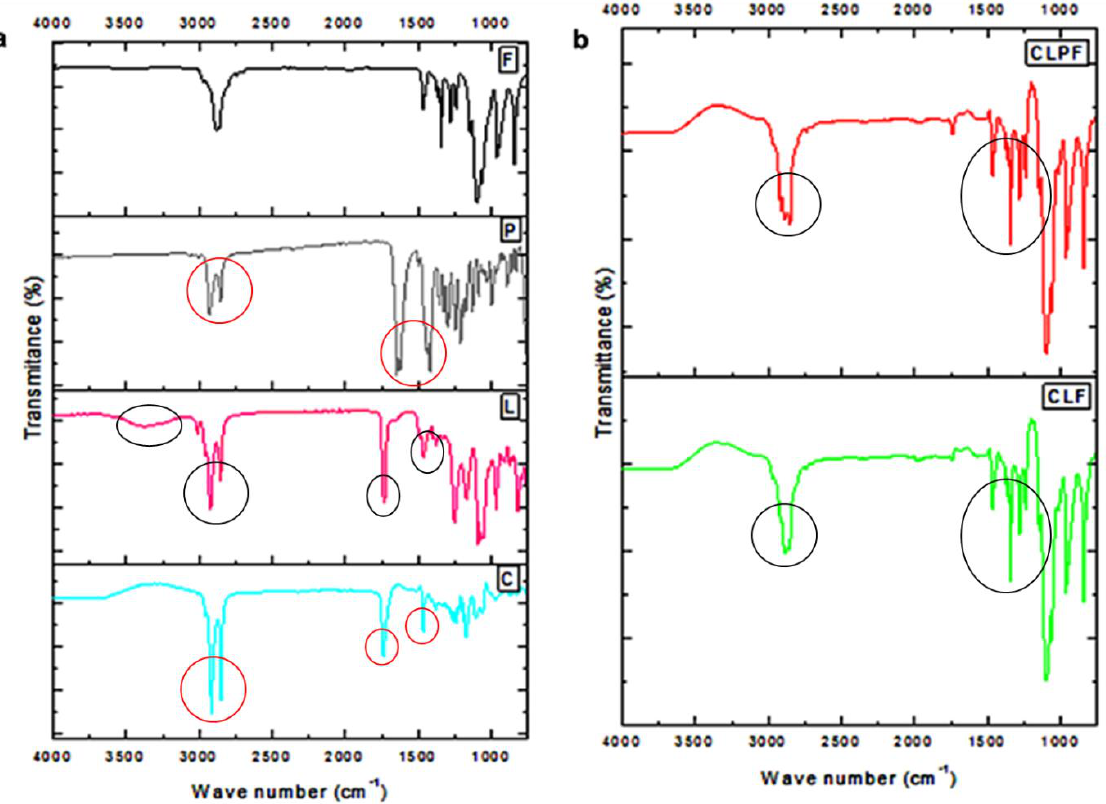
Figure 2. FTIR spectra of ( a ) all the excipients F-PF127, P-Praziquantel, L-Lecithin, C- Compritol ( b ) the formulated unloaded and PZQ-loaded SLNs.